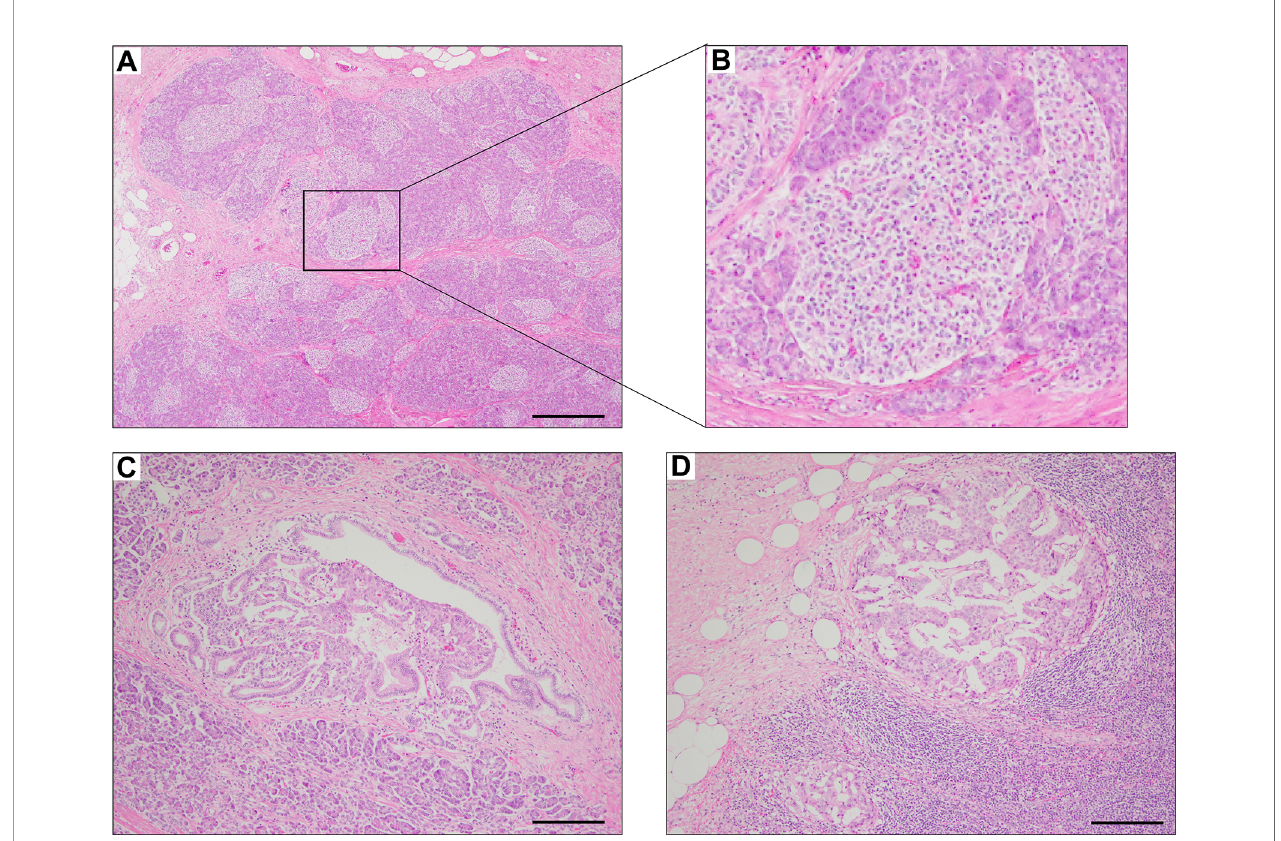
FIGURE 2 | Hematoxylin & eosin staining of pancreas surgical specimen. Staining shows the increased density of Langerhans cells from the body through the tail of the pancreas (A, B) , ductuloinsular complex (C) , and lymph node metastases (D) . Scale bars indicate 500 µm in (A) and 200 µm in (C , D)